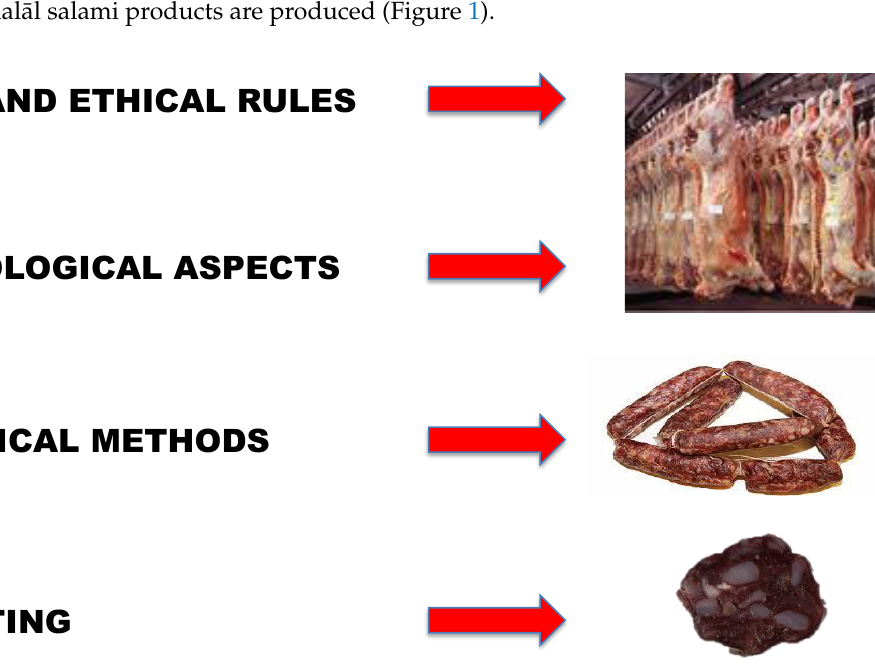
Figure 1. Main issues regarding the quality and authenticity of halal salami.